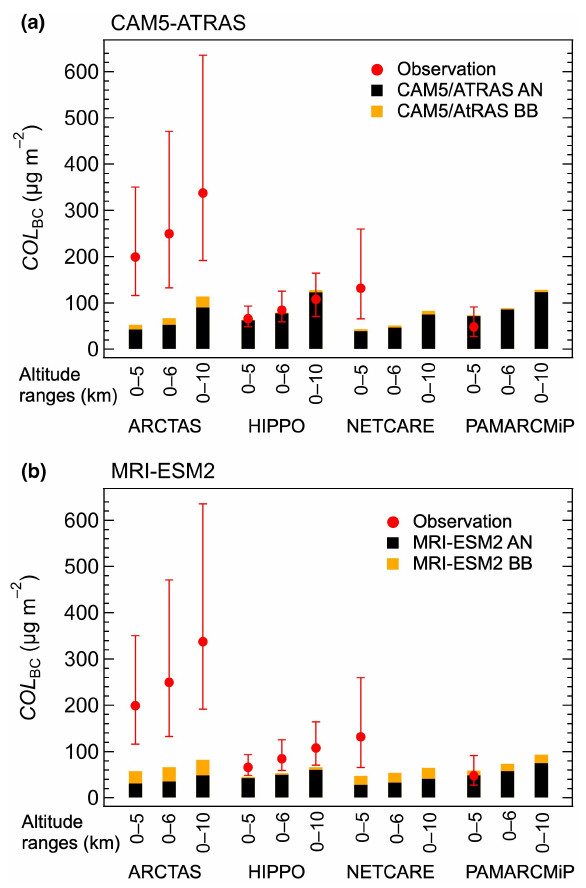
Figure D2. Observed column amounts of BC mass concentration for 0–5, 0–6, and 0–10km altitude ranges at latitudes > 66 . 5 ◦ N (COL BC , red circles) and model-calculated COL BC values (verti- cal bars). For calculated values, contributions from anthropogenic (AN) and biomass burning (BB) emissions are shown by black and orange colors, respectively. The model-calculated COL BC values were derived by calculating area-weighted averages within the ar- eas and time periods of the individual aircraft-based experiments. (a) CAM5-ATRAS model simulations. (b) MRI-ESM2 model sim- ulations.